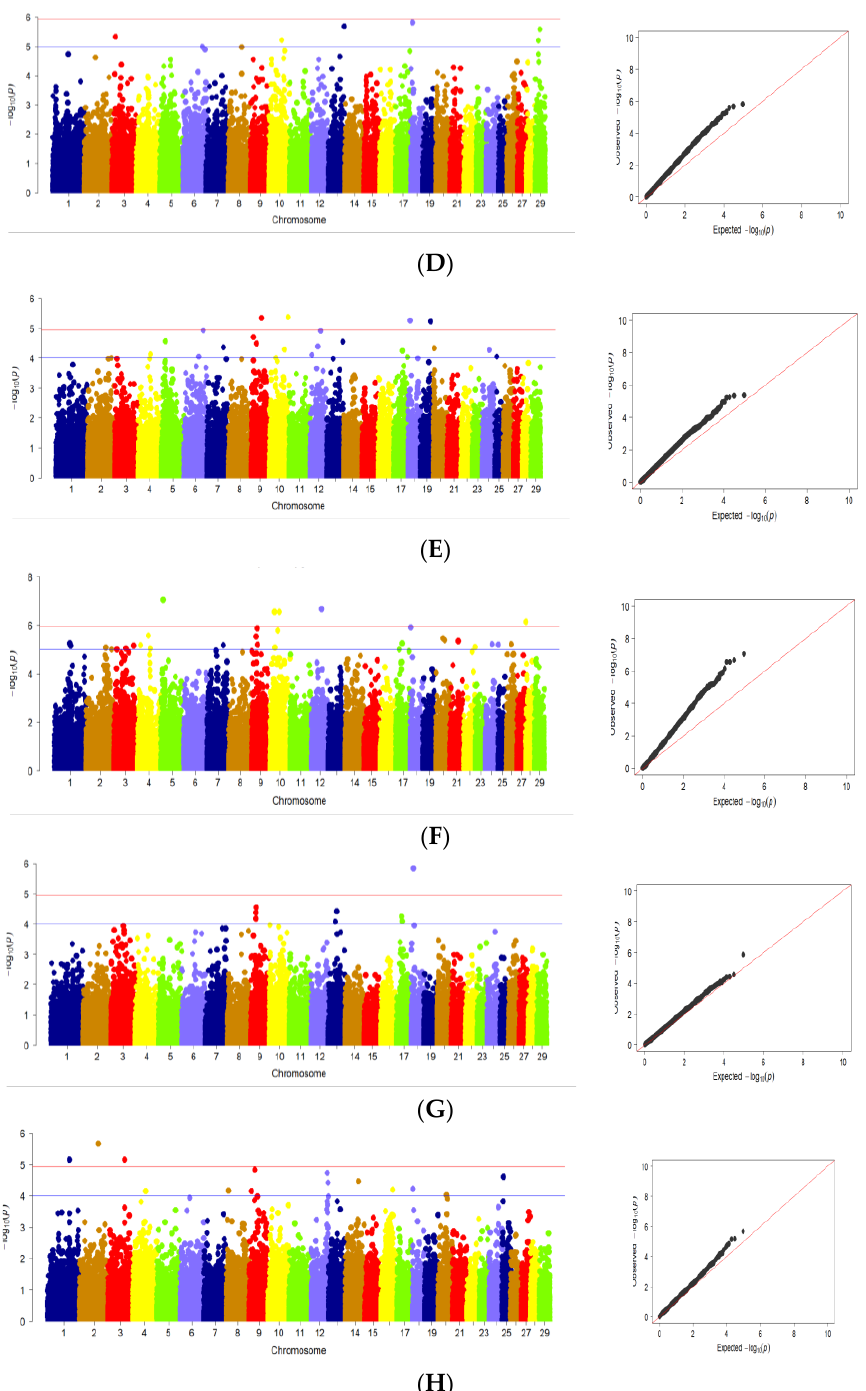
Figure 2. Manhattan plots and quantile – quantile (Q – Q) plots of GWAS for studied traits: ( A ) body weight; ( B ) withers height; ( C ) rump height; ( D ) body length; ( E ) chest perimeter; ( F ) chest width; ( G ) chest depth; ( H ) rump width. (Manhattan plots): distribution of single nucleotide mutations in goat chromosomes to the level of significance ( − log10 ( p ) according to the suggestive probabilistic value (blue line, p < 0.0001) and the Bonferroni test (red line, p < 1.05 × 10 −6 ) for the traits; (Q – Q plots): probability distribution quartile of expected and observed deviations from a normal distribution for confidence values. The dots are color-coded to visualize chromosome separation; the color does not carry any other semantic load